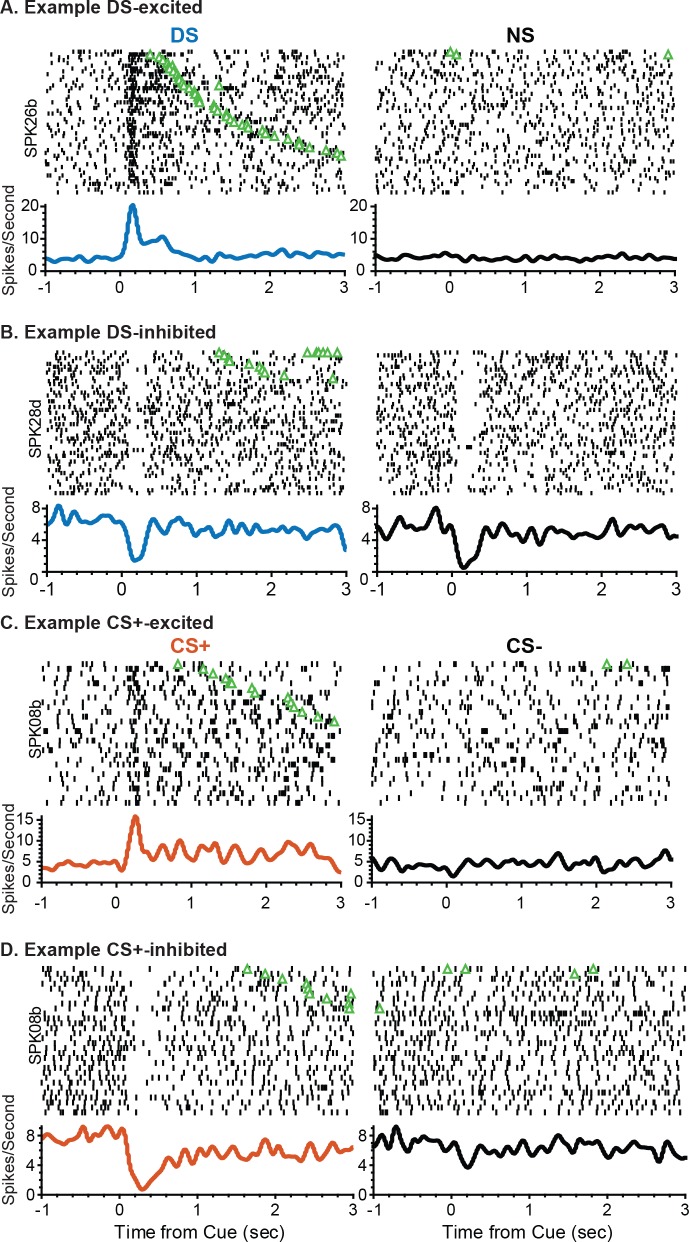
Example VP cue responses after instrumental and Pavlovian training.(A) Example rasters and corresponding histograms from a DS excited unit aligned to either DS onset (left) or NS onset. (B) Example rasters and corresponding histograms from a DS– inhibited unit aligned to either DS onset (left) or NS onset. (C) Example rasters and corresponding histograms from a CS+ excited unit aligned to either CS+ onset (left) or CS– onset. (D) Example rasters and corresponding histograms from a CS+ inhibited unit. Individual trials in all rasters are sorted by port entry (green triangle) latency.